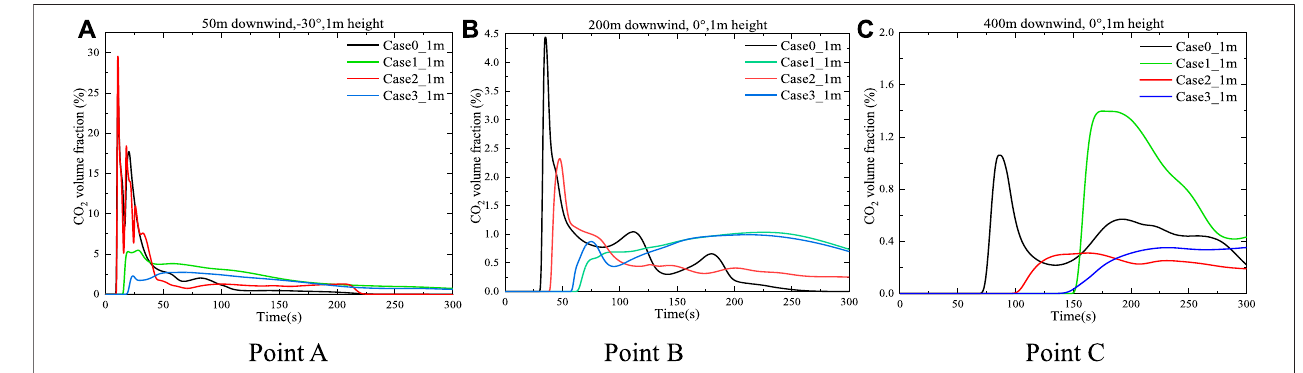
FIGURE 4 | CO 2 concentrations at different locations based on the distance from the center of the CO 2 release source.